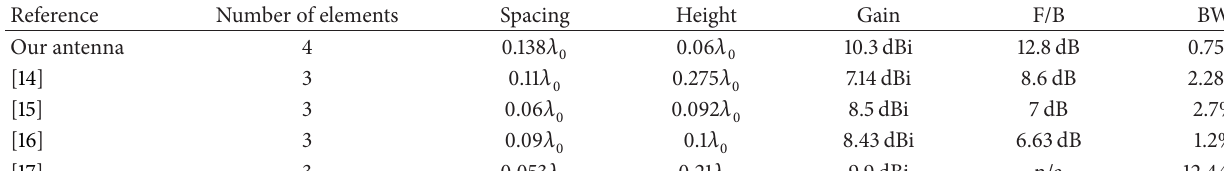
Table 2: Comparison between our antenna and other small antenna arrays in the literatures.